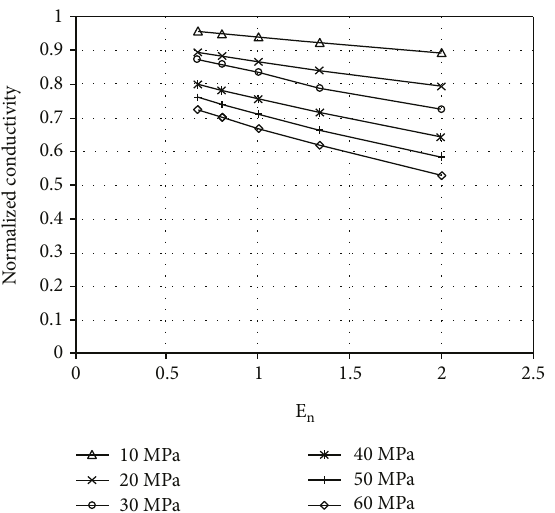
ff erent closure Figure 4: E ff ect of rock viscosity on conductivity at di ff erent closure pressures.